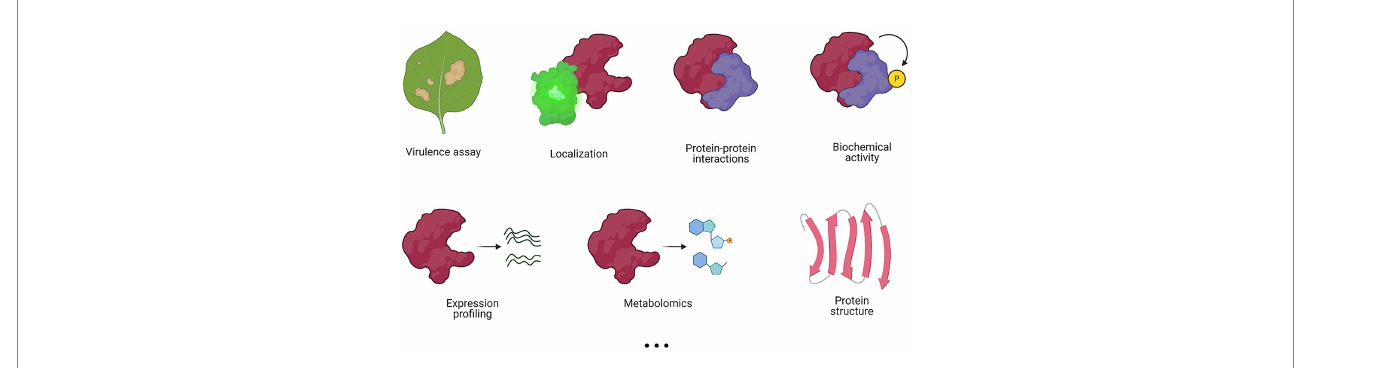
FIGURE 3 Different experimental methods to characterize a T3E. Various methods can be applied in a complementary fashion to elucidate T3E functioning. Commonly used experimental methods are listed, but this list is not